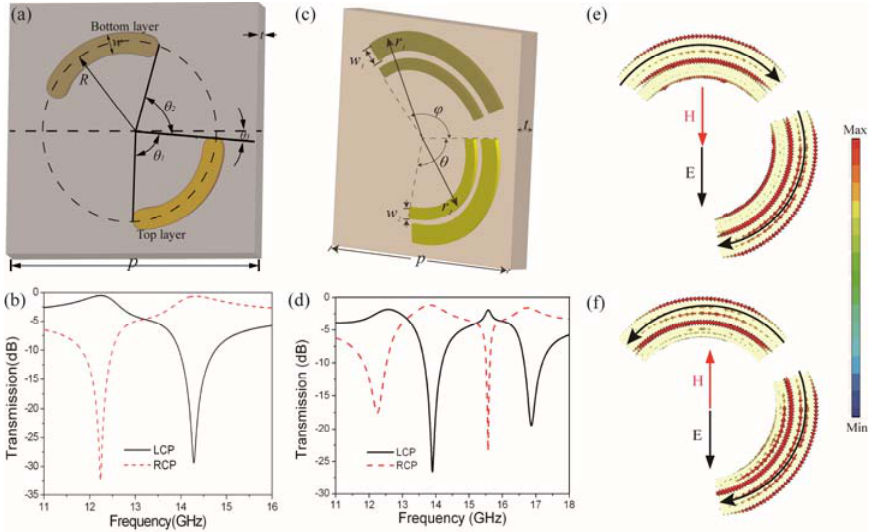
Figure 2. Chiral metamaterials based on twisted arc structures. ( a ) Unit cell with two twisted arcs; ( b ) Circular transmission spectra of ( a ) with a linearly-polarized incidence; ( c ) Unit cell with two pairs of twisted arcs; ( d ) Circular transmission spectra of ( c ) with linearly-polarized incidence; ( e , f ) The surface current distribution of the chiral metamaterial in ( c ) at the first and second resonances, respectively. ( a , b ) are reproduced with permission [42]. Copyright IEEE, 2014; ( c – f ) are reproduced with permission [43]. Copyright AIP Publishing LLC, 2012.